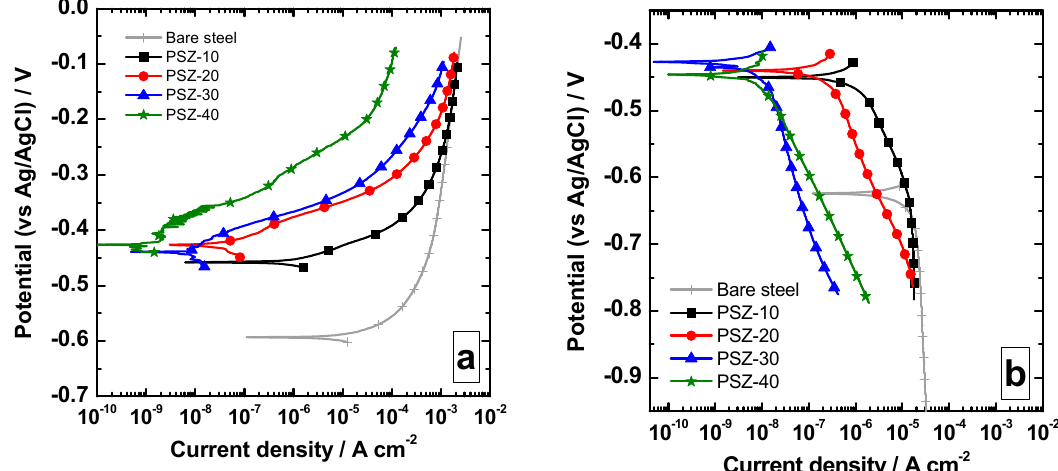
Figure 5. Anodic ( a ) and cathodic ( b ) polarization curves collected over the investigated samples in 0.1 M NaCl.